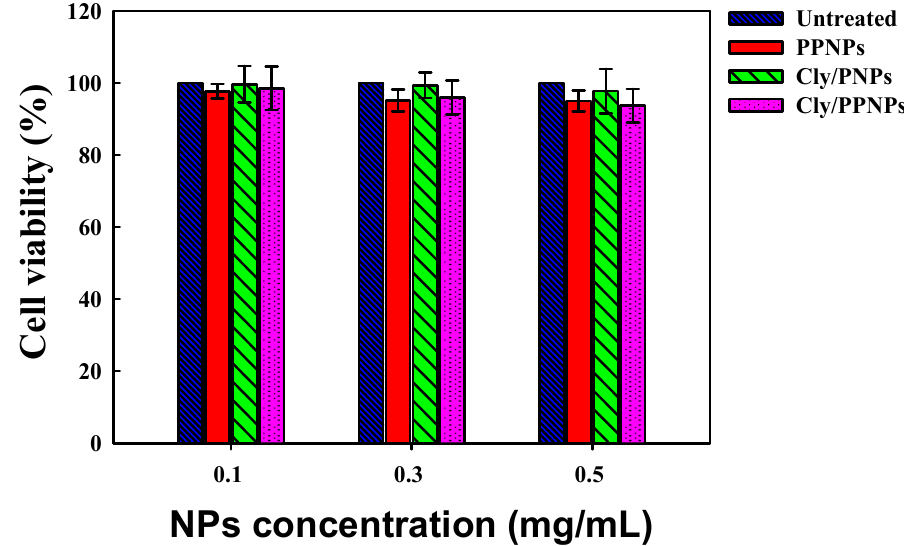
Figure 5. Viability (%) of L929 mouse fibroblast cells following 24 h of exposure to various concentrations of NPs ( n = 8).